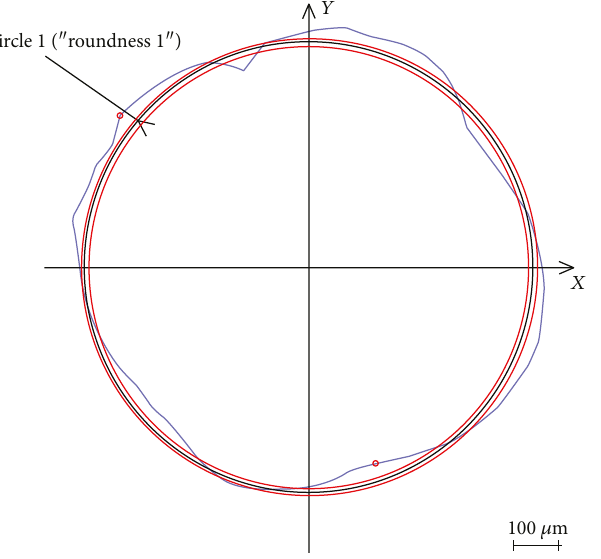
Figure 9: Circularity measurement using CMM.